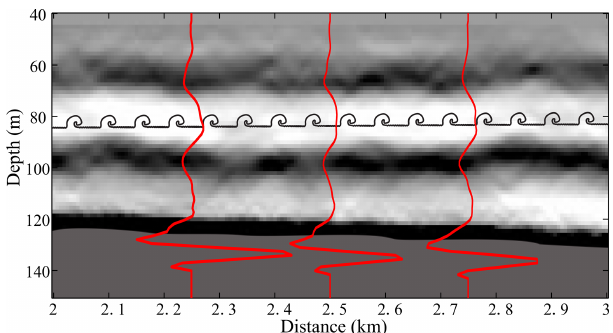
Figure 9. Schematic of the K-H instability. The red lines are the seismic waves, and the black billows represent the K-H